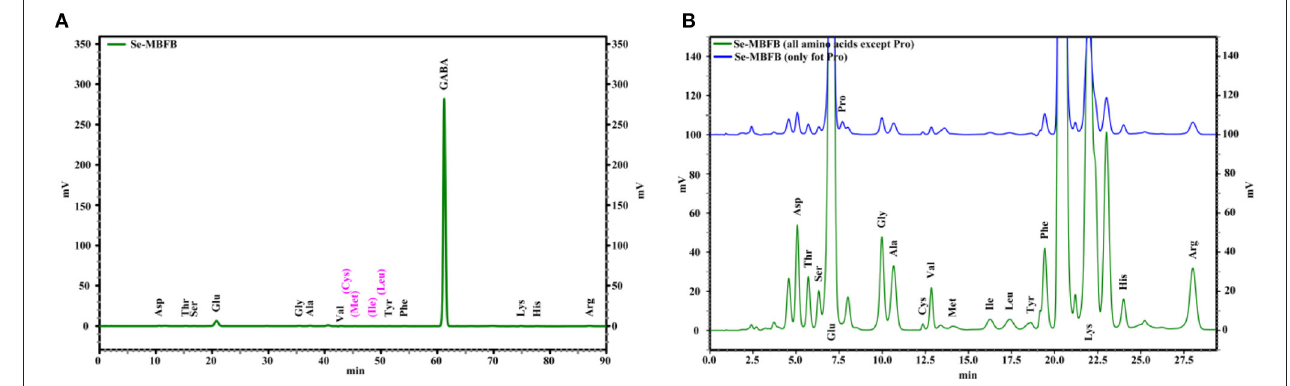
FIGURE 1 | The IC chromatograms of the amino acids of free amino acid (A) and free peptides and protein hydrolysate (B) in Se-MBFB.